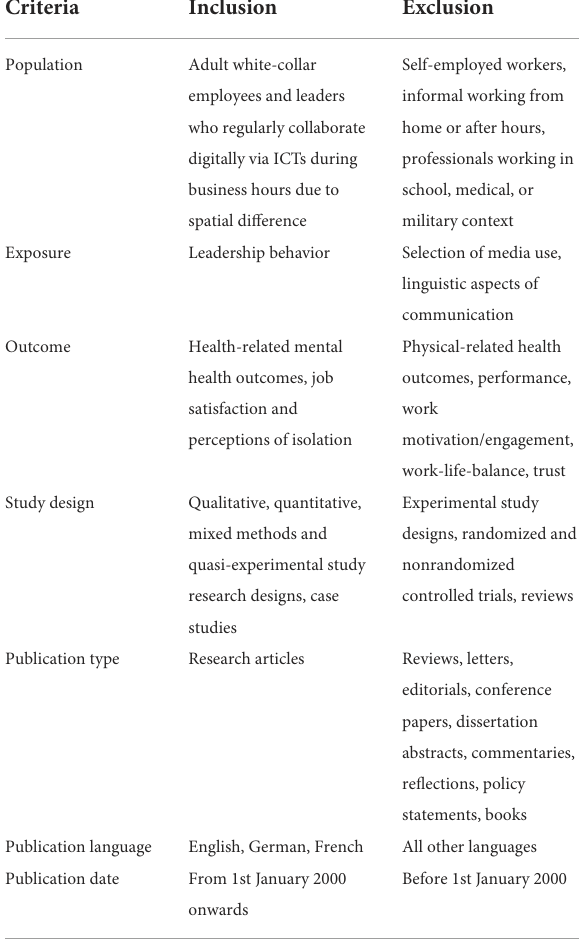
TABLE 1 Eligibility criteria for study